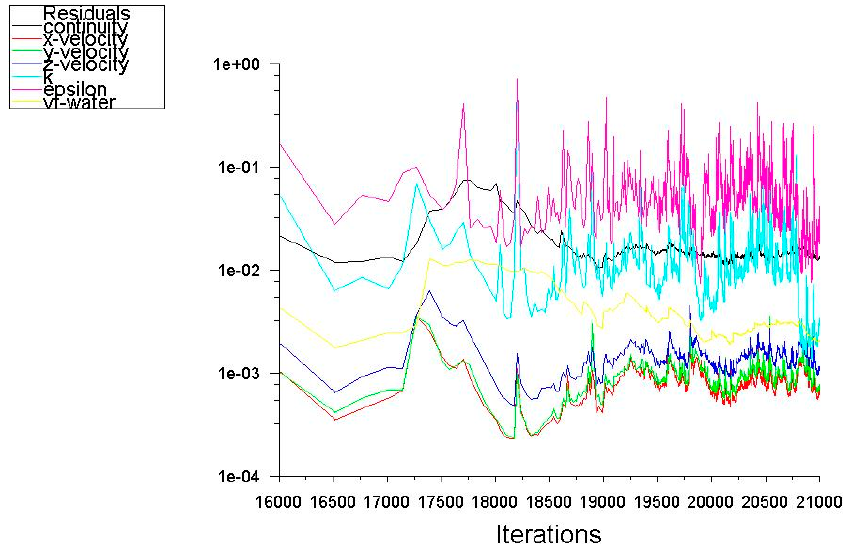
Figure 12. Convergence plot of residuals for the pipe.